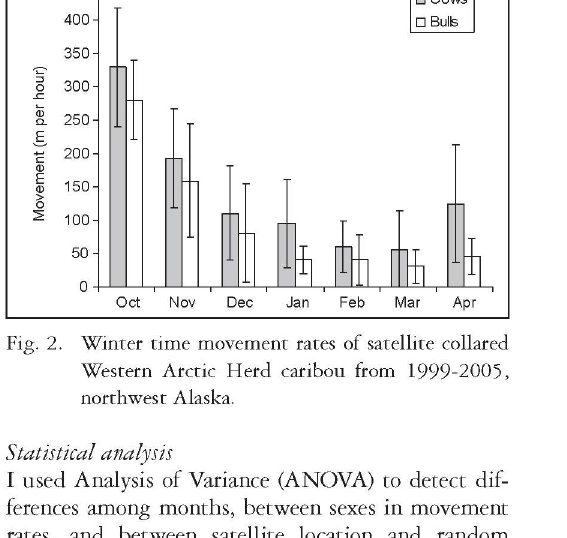
Fig. 2. Winter time movement rates of satellite collared Western Arctic Herd caribou from 1999-2005, northwest